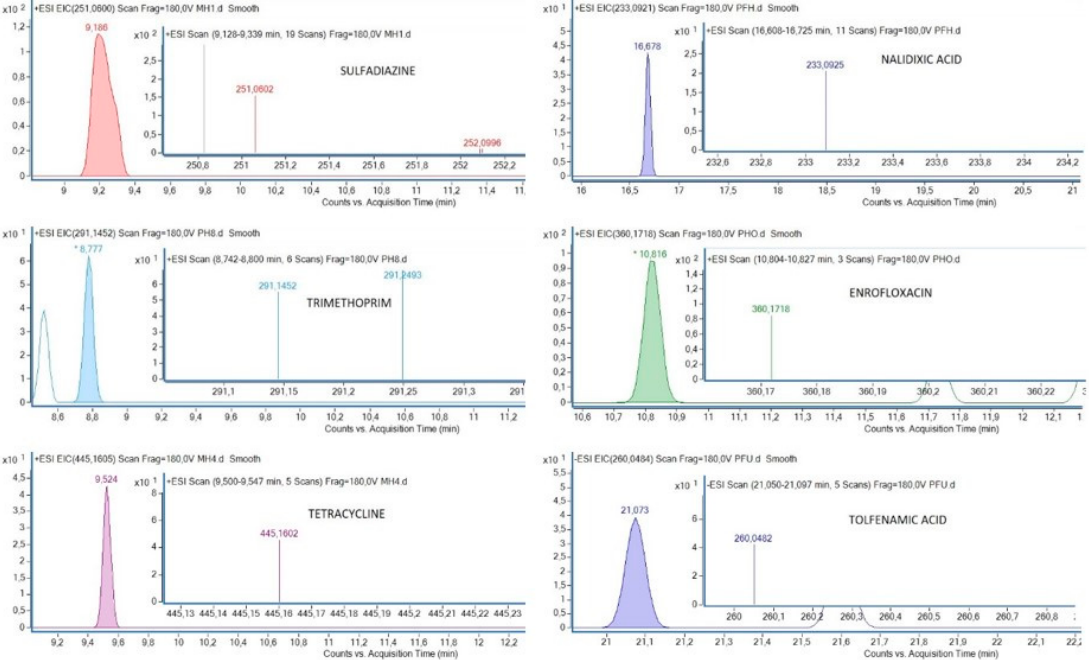
Figure 2. Chromatograms of some samples with the detected compounds. Table 4. Frequency of detection and concentrations of antibiotics and NSAIDs in plasma of 29 griffon vulture nestlings.